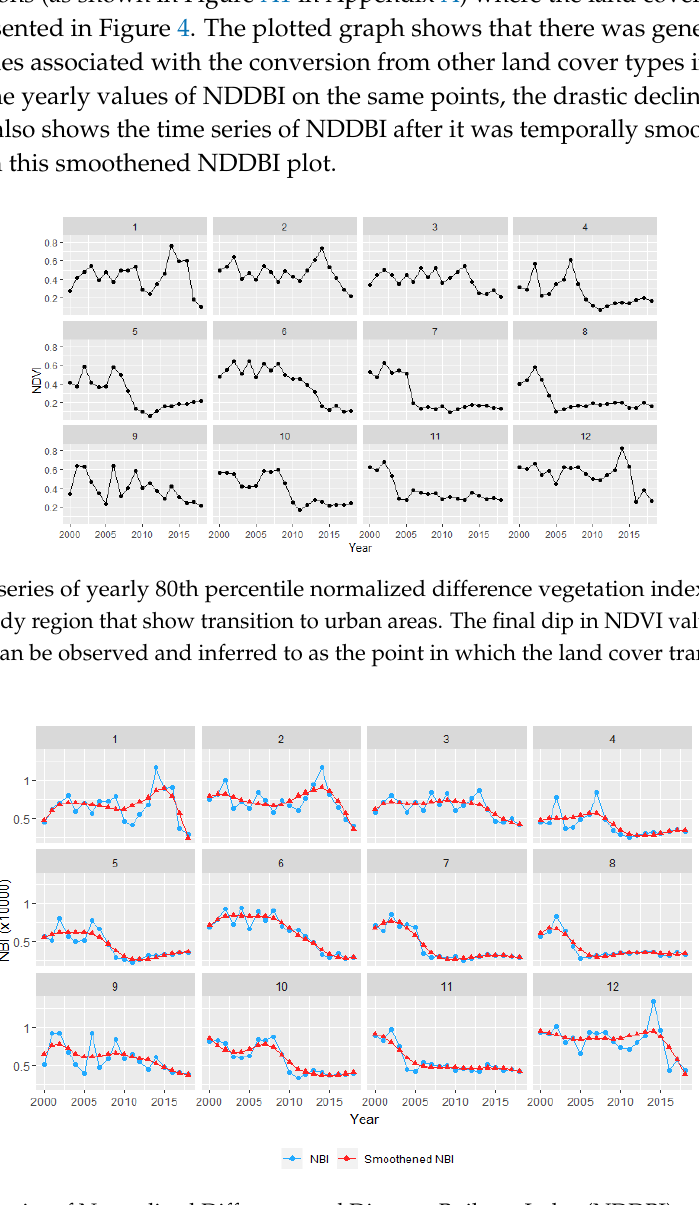
Figure 5. Time series of Normalized Difference and Distance Built-up Index (NDDBI) and Smoothened NDDBI in the same 12 points obtained after combining NDVI and distance layers from OSM data: The NDDBI data follows a similar pattern to that of the NDVI plot.The smoothened NDDBI makes the point of change in land-ctover type more